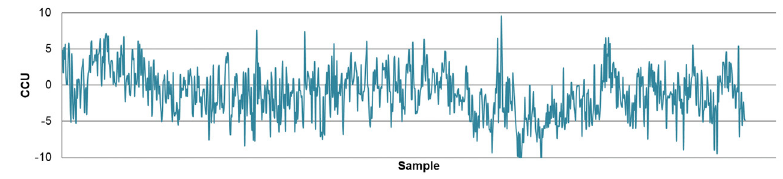
Figure A21. Prediction error of PMM model testing dataset for CCU output variable.